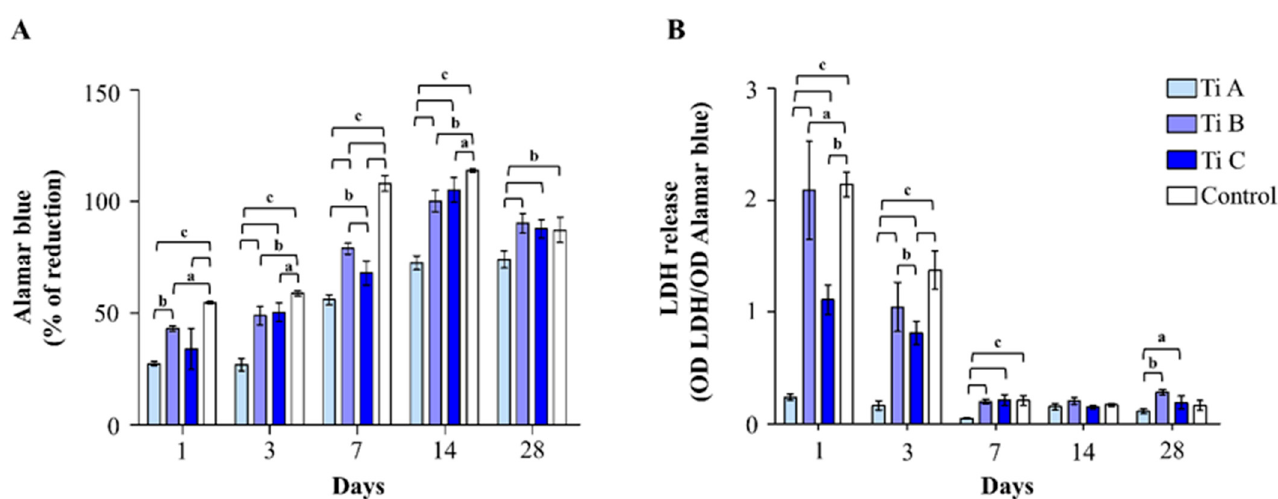
Figure 3. ( A ) The alamarBlue assay in DPSCs cultured on Titanium A, B, C and coverslip scaffold (control) for 1, 3, 7, 14, and 28 days. The histogram represents the % of alamarBlue reduction values. Data are the mean ( ± SD) of three different experiments. ( B ) LDH assay of DPSCs cultured on Titanium A, B, C and coverslip scaffold (control) for 1, 3, 7, 14, and 28 days. LDH released is reported as OD LDH/OD alamarBlue ratio. Data shown are the mean ( ± SD) of three separate experiments. a = p < 0.01; b = p < 0.001; c = p < 0.0001.